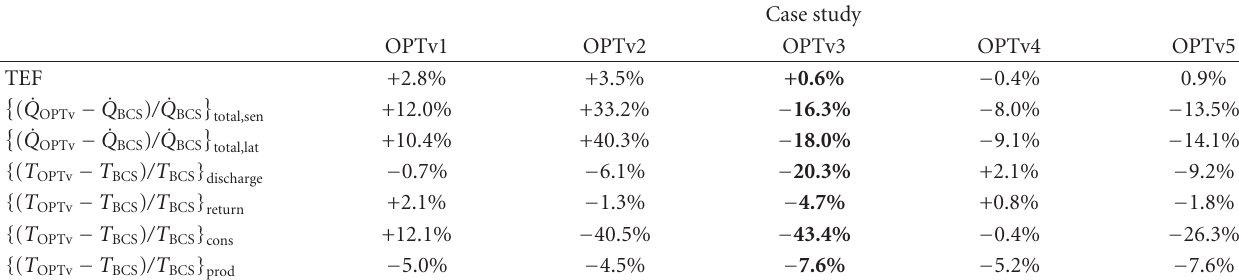
Table 5: Thermal and temperature ratios relatively to BSC—fans velocity parametric study.